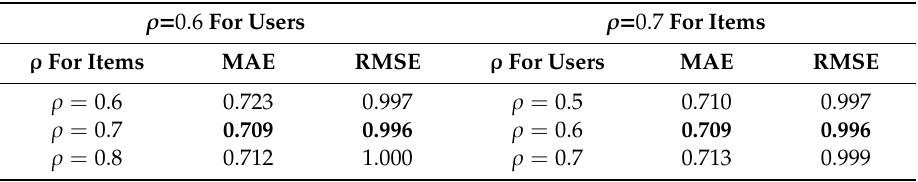
Table 11. Performance comparisons among di ff erent values of ρ . ρ = 0.6 For